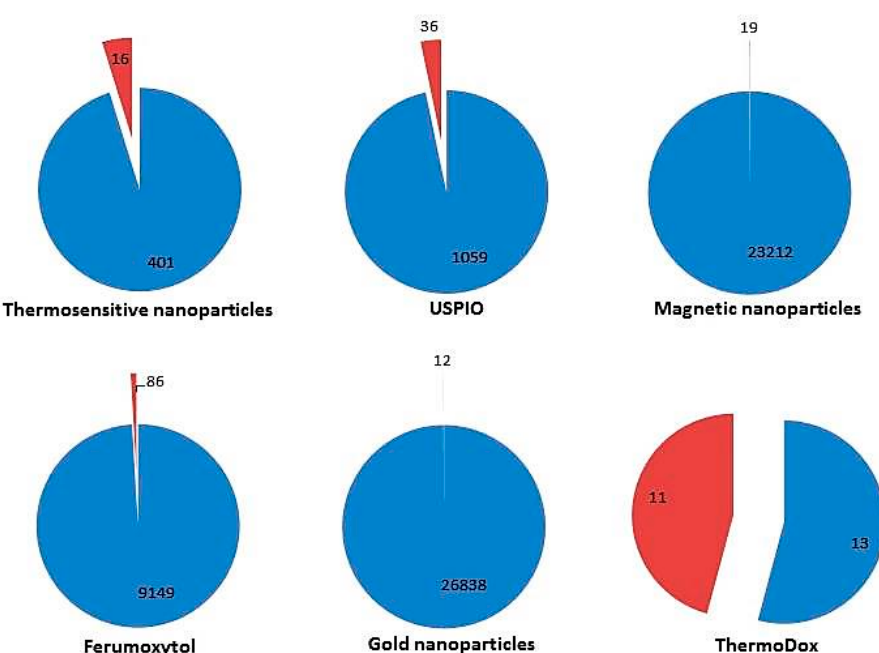
Figure 2. Number of publications (blue) versus clinical trials (red) related to thermosensitive nanomaterials, USPIOs, MNPs, GNPs, Ferumoxytol and ThermoDox®. Data reported here reflect manuscripts available through PubMed database and clinicaltrials.gov up to November 2018.